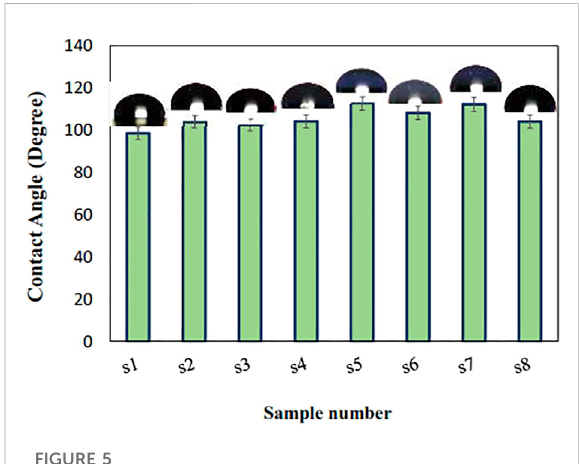
FIGURE 5 Results of contact angle tests for different shed